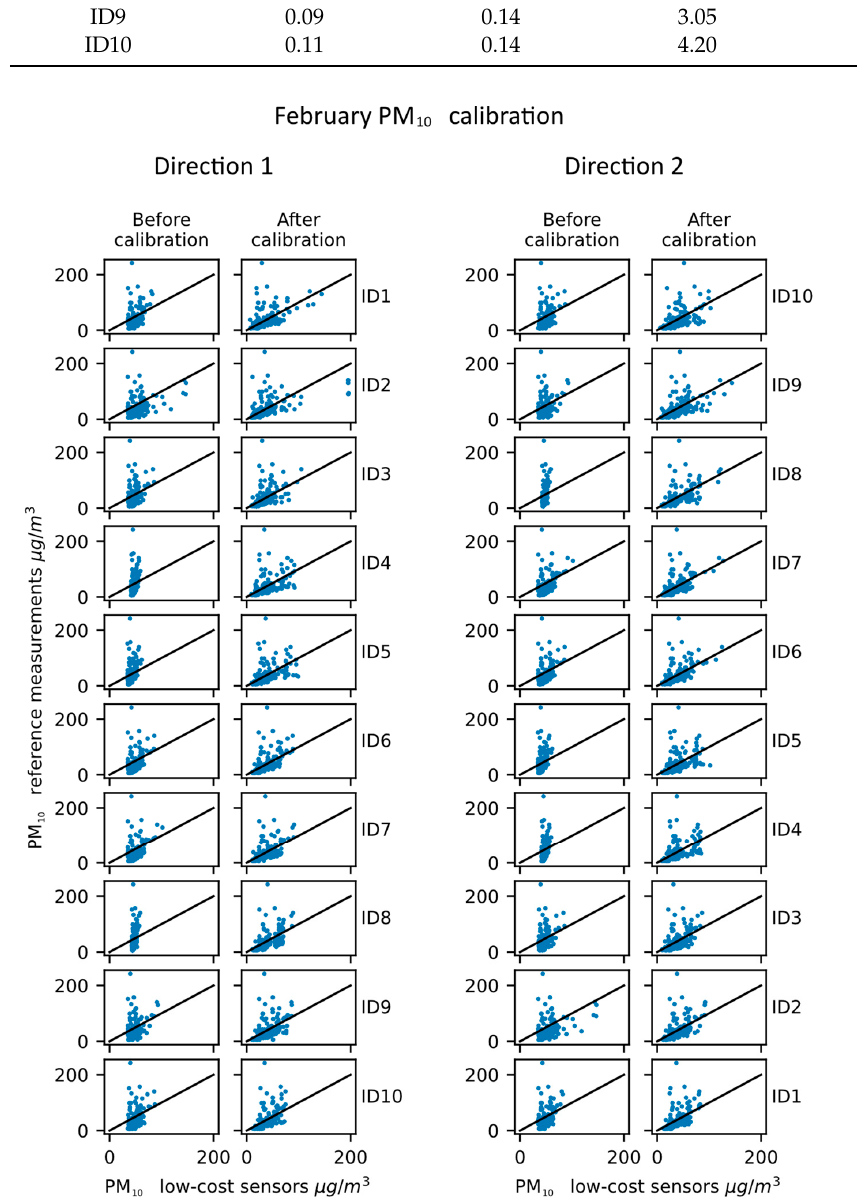
Figure 6. PM 10 calibration propagation—February